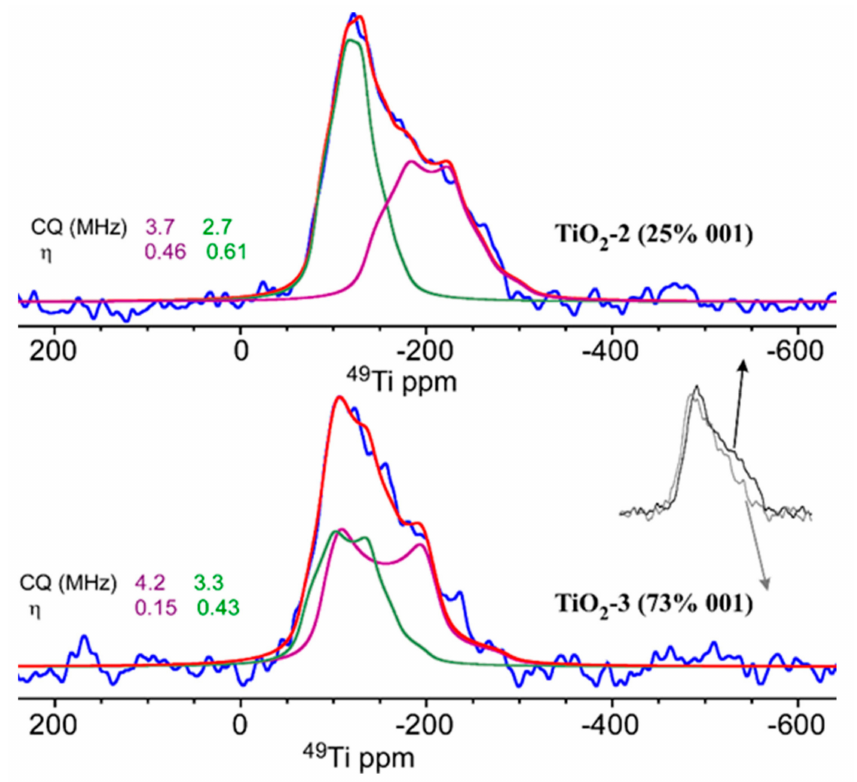
Figure 9. 49 Ti FAM-enhanced MAS ssNMR spectra of TiO 2 -2 and TiO 2 -3 samples with their deconvolution to a minimal set of two sites. Overlay of the spectra shows the variations between the two